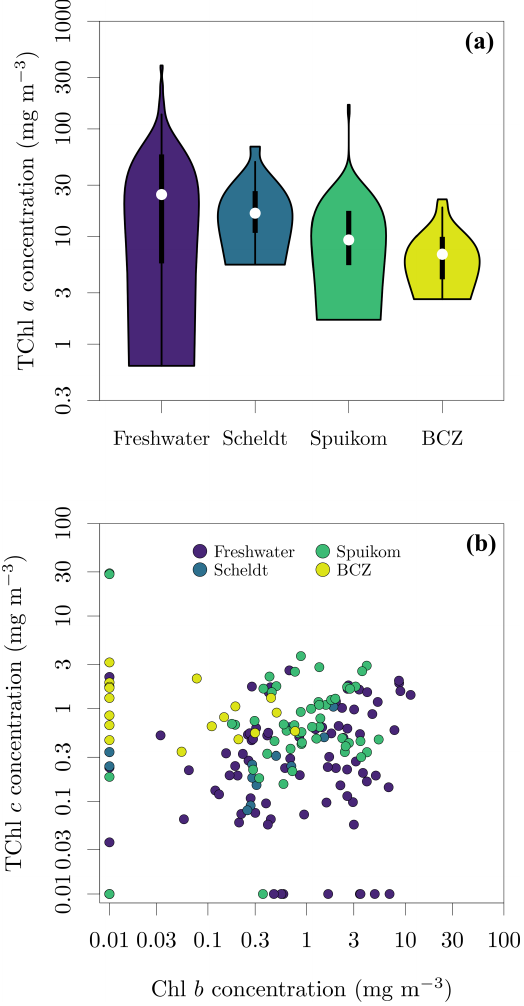
Figure 13. Pigment concentrations in Belgian water systems. (a) Total chlorophyll a (TChl a ) concentration; and (b) relation between monovinyl chlorophyll b (Chl b ) and total chlorophyll c (TChl c ) concentrations. TChl a = monovinyl chlorophyll a + chlorophyllide a , TChl c = chlorophyll c 1 c 2 + divinyl chloro- phyll c 3 (cf. Table 6). A value of 0.01mgm − 3 was added to rep- resent in the log-log plot the samples with concentrations below the detection limit.